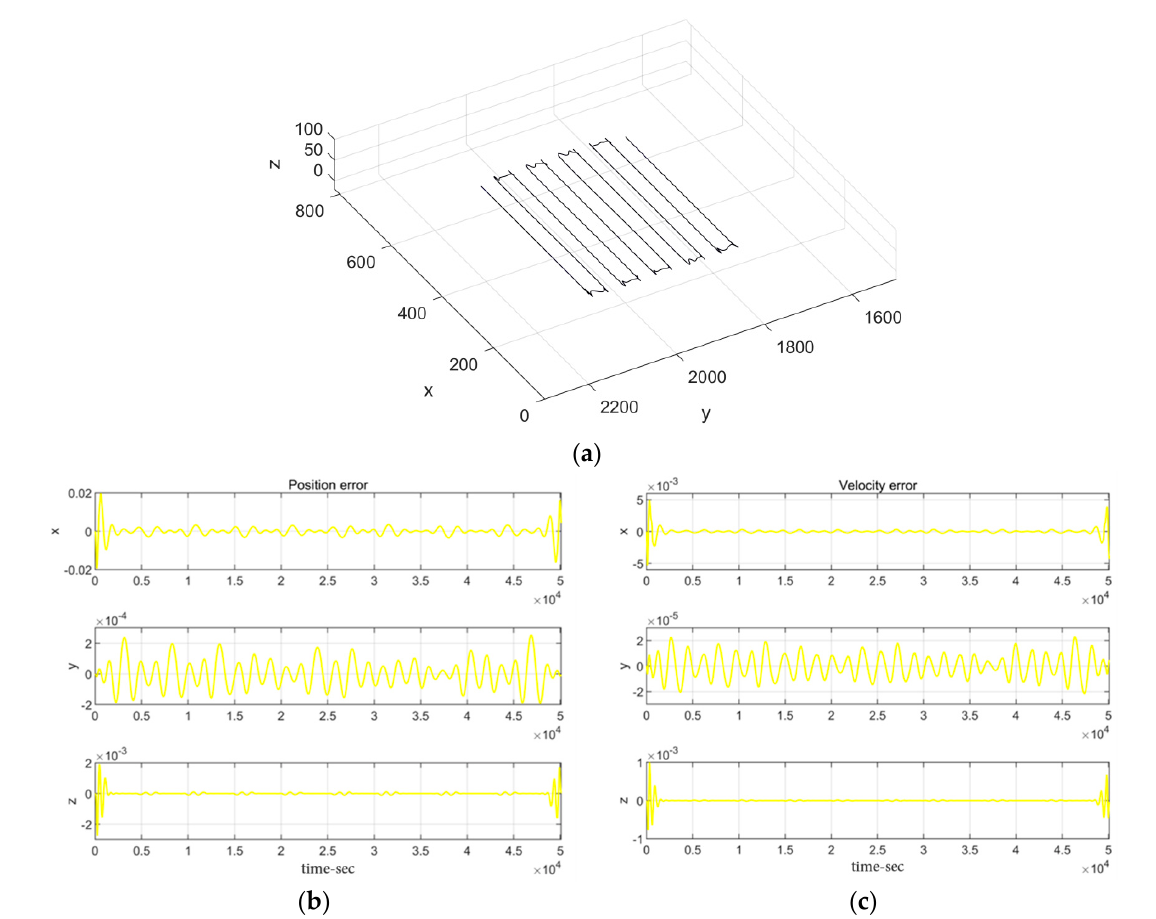
Figure 13. Relations between the desired trajectory and actual trajectory. ( a ) Comparison of desired trajectory and actual trajectory. ( b ) Position error. ( c ) Velocity error.